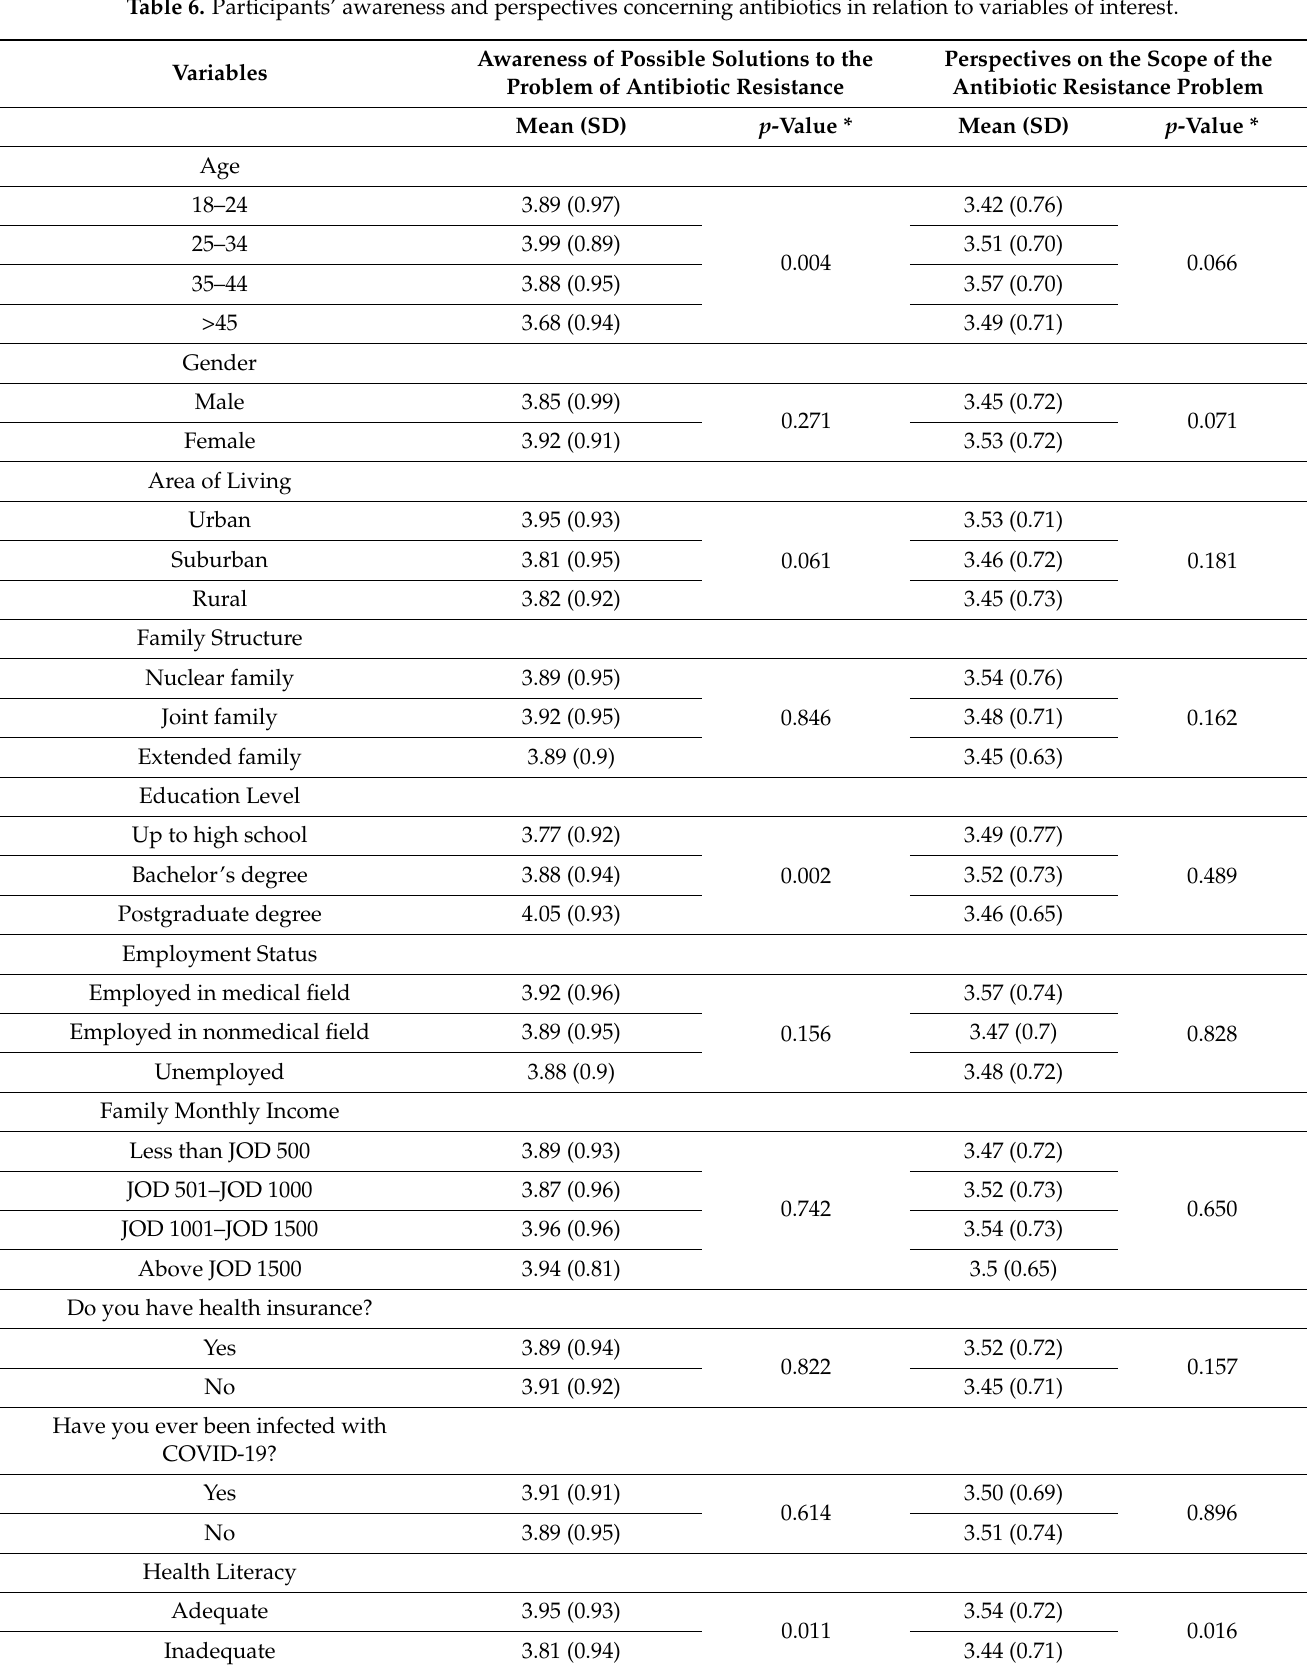
Table 6. Participants’ awareness and perspectives concerning antibiotics in relation to variables of